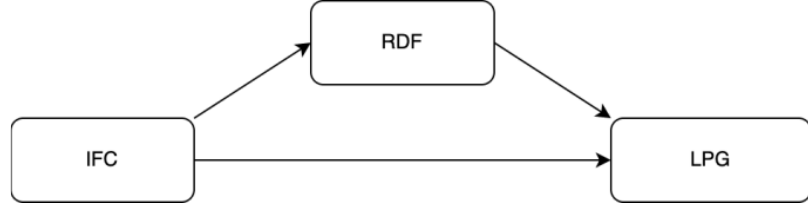
Figure 13. The pattern in IFC-to-Graph conversion.